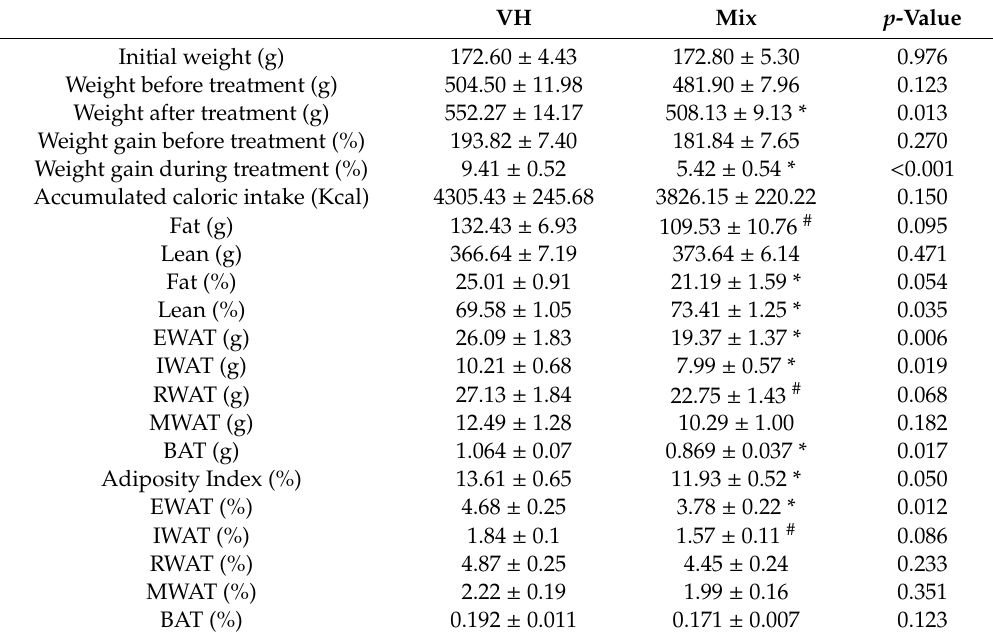
Table 1. Biometric measures of rats fed a cafeteria (CAF) diet treated with a mix of natural bioactive ingredients or the